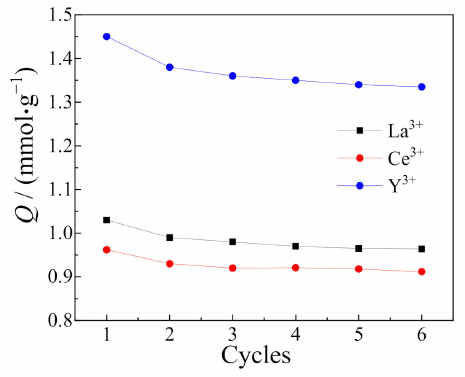
Figure 12. Regeneration of